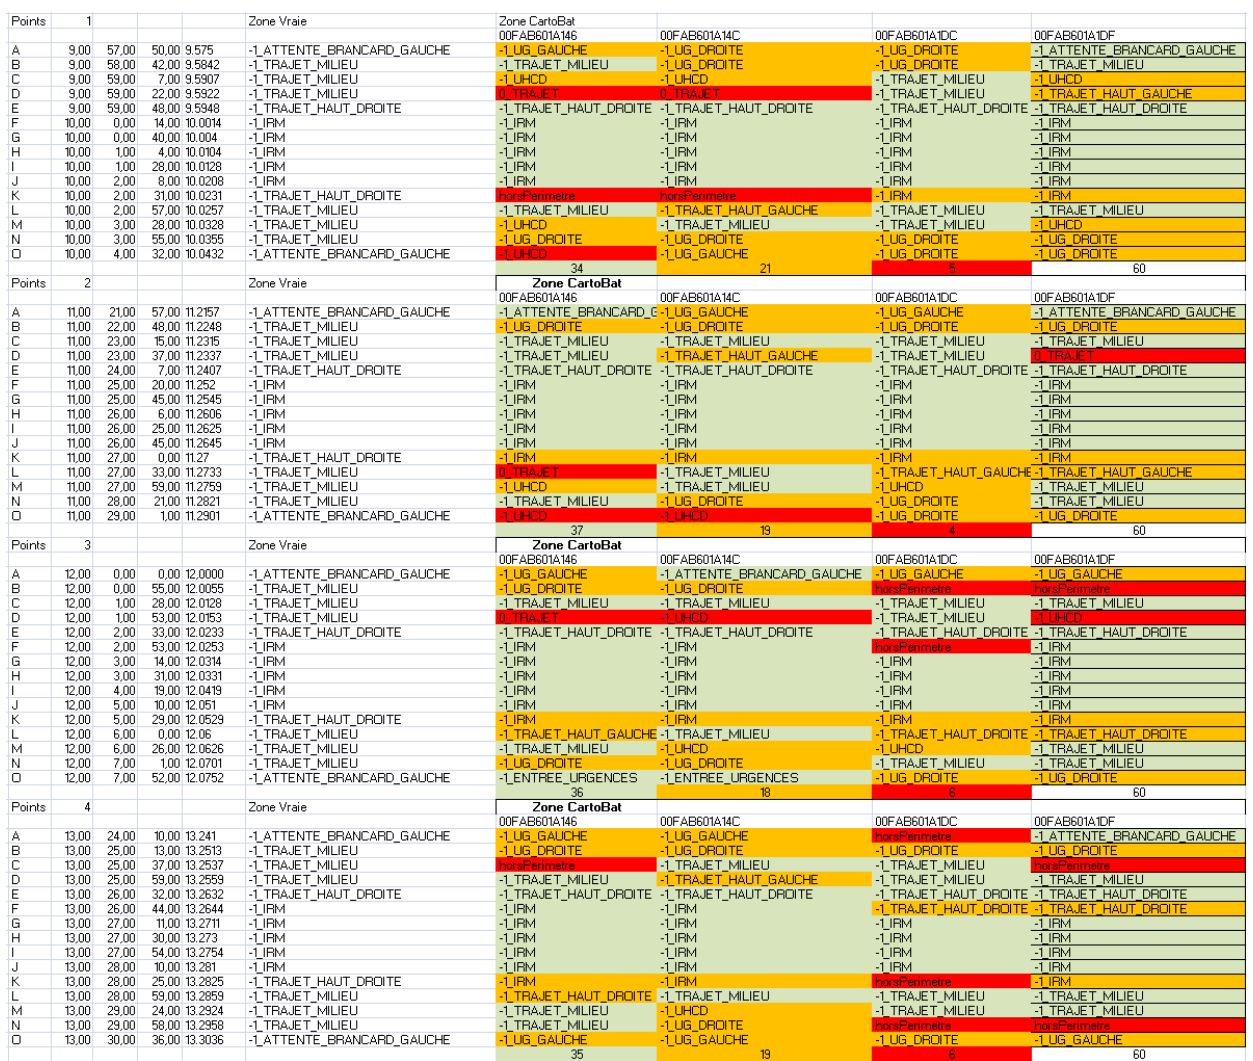
Figure 12. Analyses file for positioning reliability for four tags and four destinations. Table 2. Positioning determination